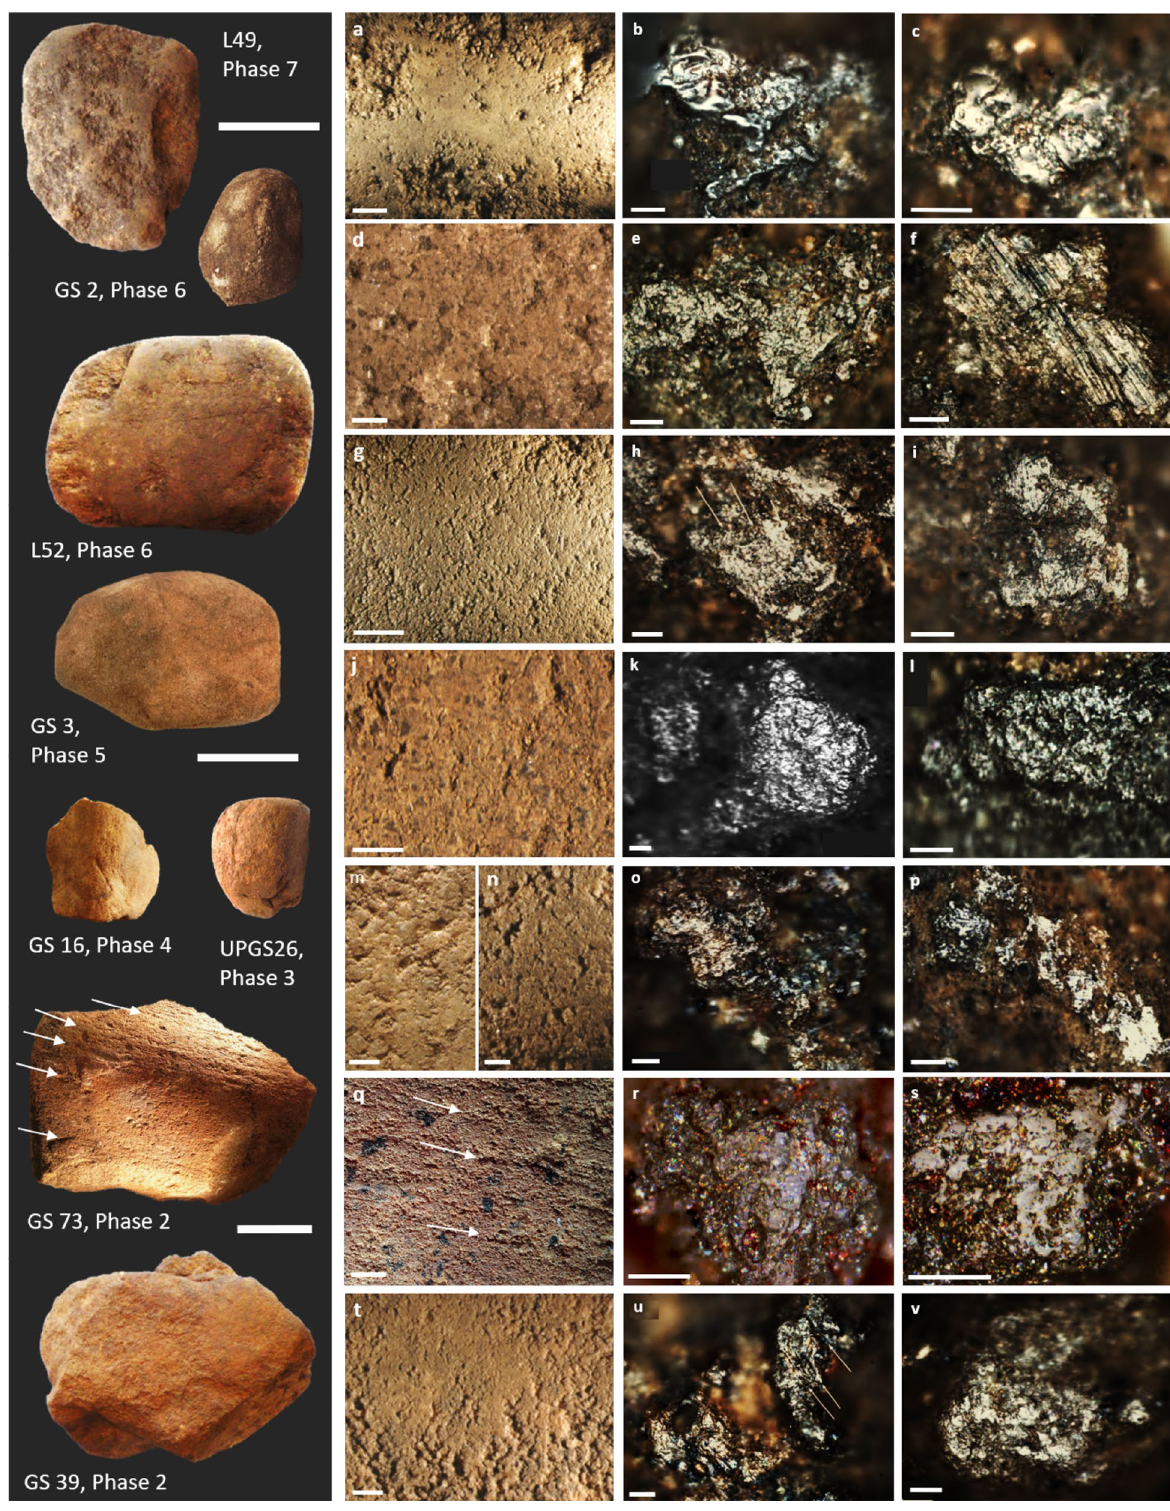
Figure 3. Examples of grinding stones from Madjedbebe with usewear consistent with plant processing/seed grinding from Phases 7–2. Under low magnification, the more elevated quartz grains on the surface of the sandstone are levelled and sometimes striations are visible. Under high magnification, use-polish is very bright and restricted to the more elevated part of the relatively rough quartz grains, creating a reticular or net-like pattern with a distinct boundary between the polished and unpolished zones to indicate the processing of a harder plant material such as seeds. In instances where the use-polish extends into the lower recesses of the grains (e.g., b, c), we infer the processing of softer plant materials. ( a – c ) Usewear on L49 from Phase 7; ( d – f ) usewear on GS2 from Phase 6; ( g – i ) usewear on L52 from Phase 6; ( j – l ) usewear on GS3 from Phase 5; ( m , o ) usewear on GS16 from Phase 4; ( n , p ) usewear on UPGS26 from Phase 3; ( q – s ) usewear on GS73 from Phase 2; ( t – v ) usewear on GS39, Phase 2. Scale bars for artefact images are 5 cm; scale bars for low magnification images vary: ( a , g ) 5 mm; ( m , n , q , t ) 2 mm; ( d , j ) 1 mm; scale bars for high magnification images are 0.05